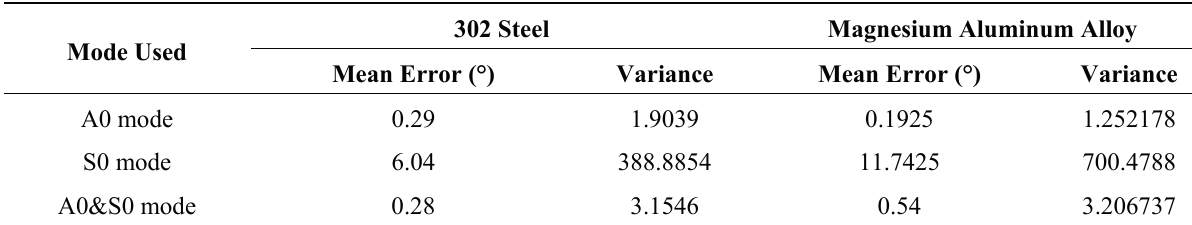
Table 2. The orientation results in different